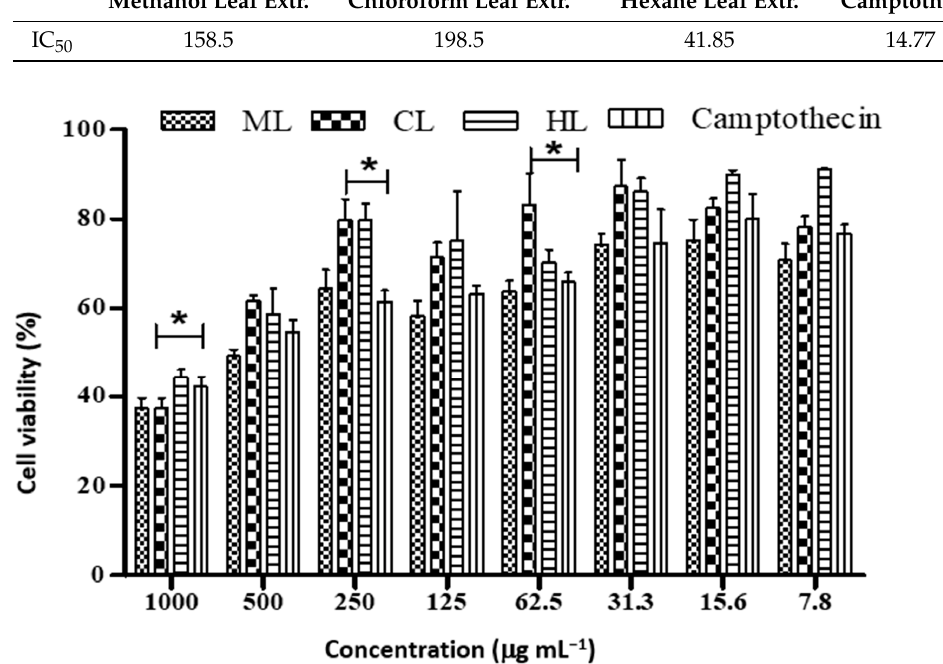
Figure 3. Cell viability of MCF-7 cancer cell lines treated with different concentrations of nanoparticles synthesized from D. villosa leaves and stem extract at room temperature and 80 °C. * (ML vs. Camptothecin), p < 0.05; *** (ML vs. Camptothecin), p < 0.001. The viability of the HEK 293 cell line was observed to be higher on exposure to methanolic leaves extract of D. villosa (IC 50 41.85 µg mL − 1 ), chloroform leaves extract (IC 50 of 198.5 µg mL − 1 ) and hexane leaf extract (IC 50 of 158.5 µg mL − 1 ) compared to camptothecin (IC 50 of 14.77 µg mL − 1 ) (Table 6 and Figure 4). Table 6. IC 50 values of methanol, chloroform and hexane extract of D. villosa leaf against HEK293 cell. Methanol Leaf Extr.